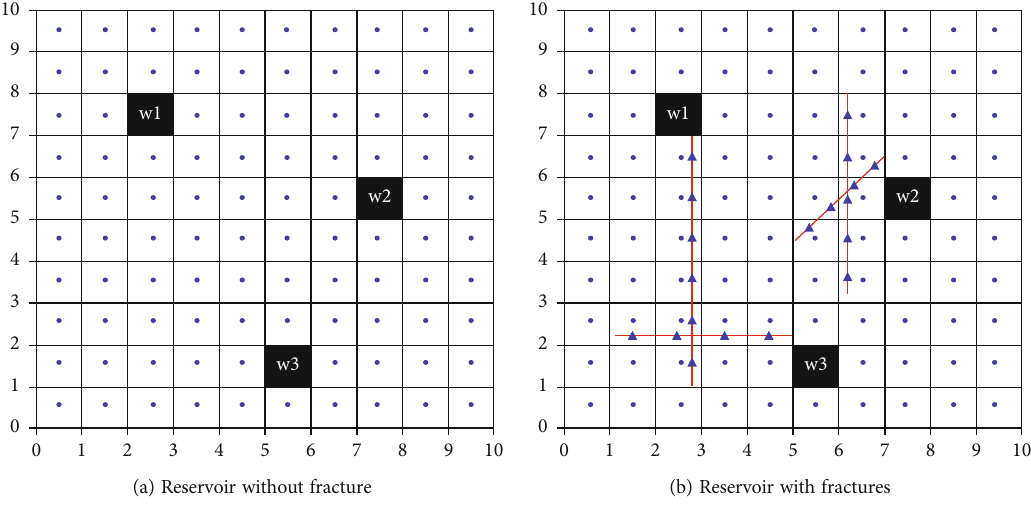
Figure 3: Illustration of well placement optimization for a reservoir with or without